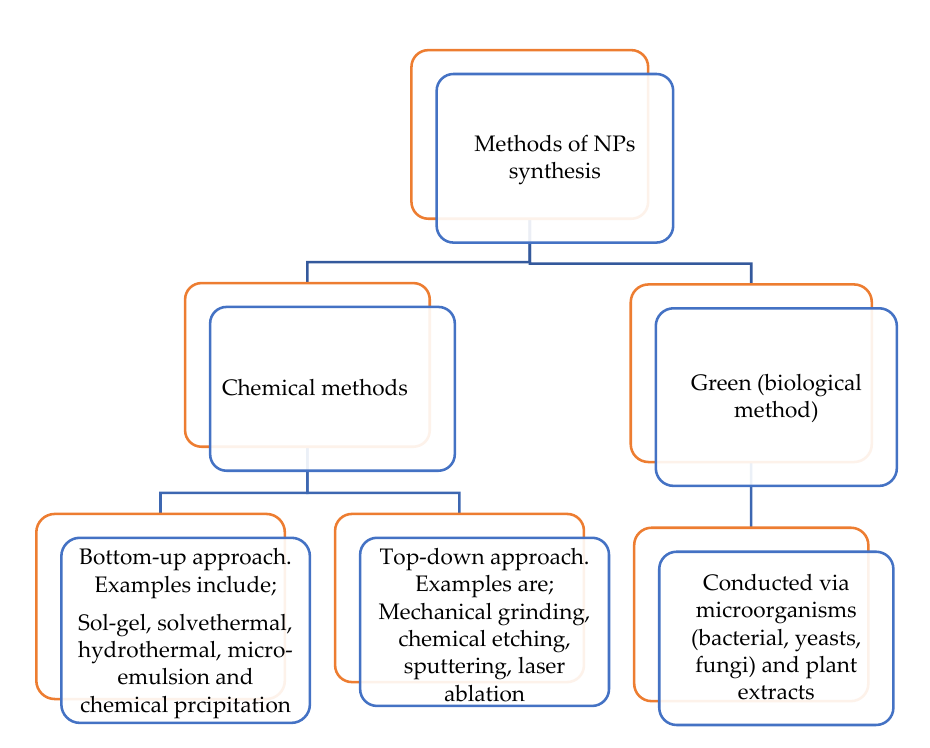
Figure 6. Nanomaterial synthetic methods.